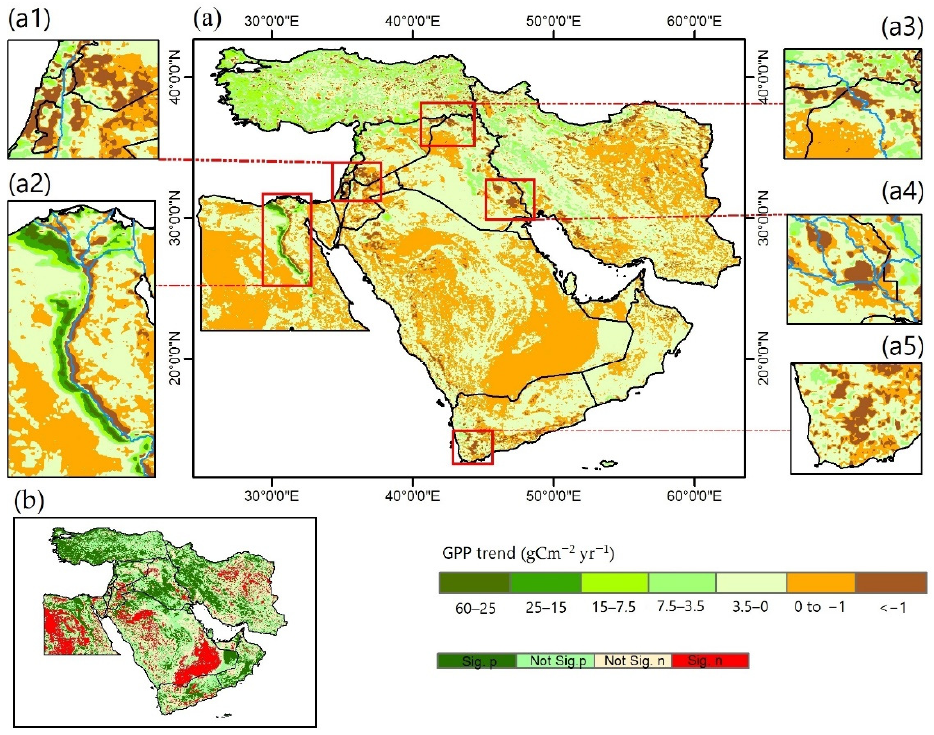
Figure 3. Trends of long-term intra-annual GLASS-GPP series for the period of 1982–2016: ( a ) the magnitude of annual change given in gCm − 2 yr − 1 ; ( b ) the Z-statistic values of trends at a 95% confidence interval. In addition, the results are plotted for specific regions over the Middle East.